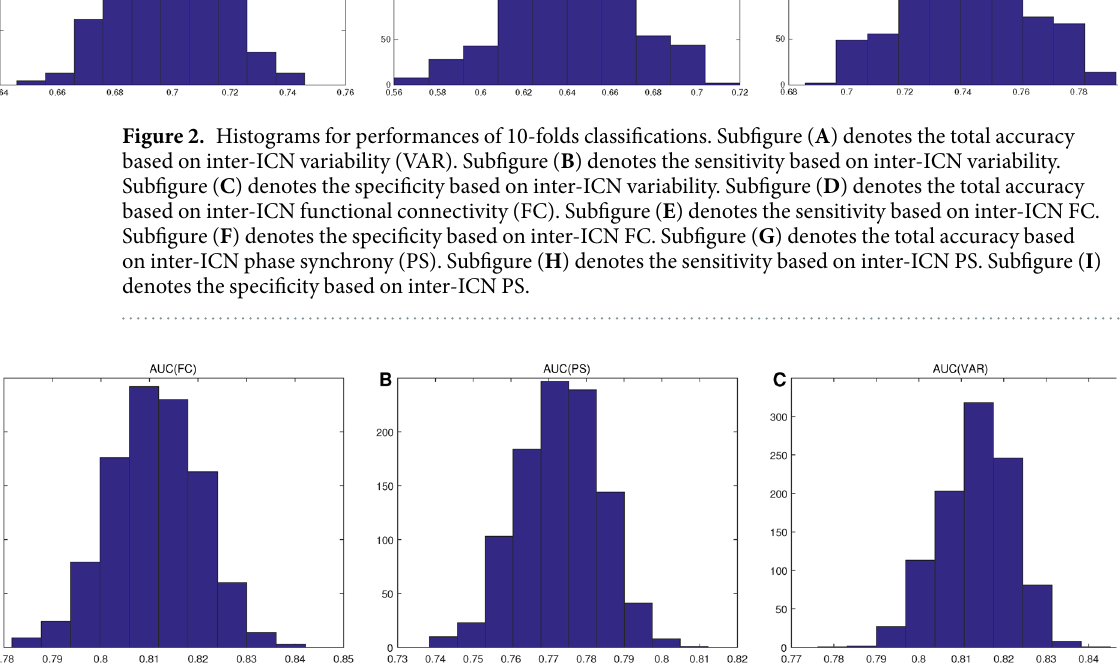
Figure 3. Histograms of AUC values based on 10-folds CV. Subfigure ( A ) denotes histogram of AUC values based on inter-ICN functional connectivity (FC). Subfigure ( B ) denotes histogram of AUC values based on inter-ICN phase synchrony (PS). Subfigure ( C ) denotes histogram of AUC values based on inter-ICN variability